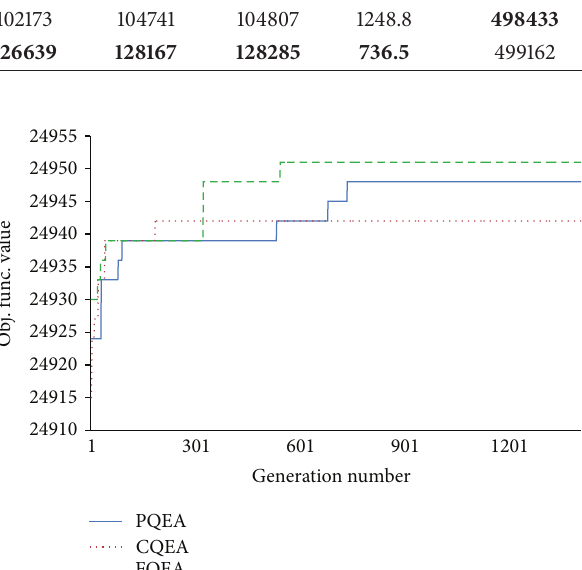
Figure 33: Convergence graph of PQEA, CQEA, and FQEA on 0- 1 knapsack problem profit ceiling data instances with number of items, 𝑀 , being 200 and capacity, 𝐶 , being 1% of total weight.